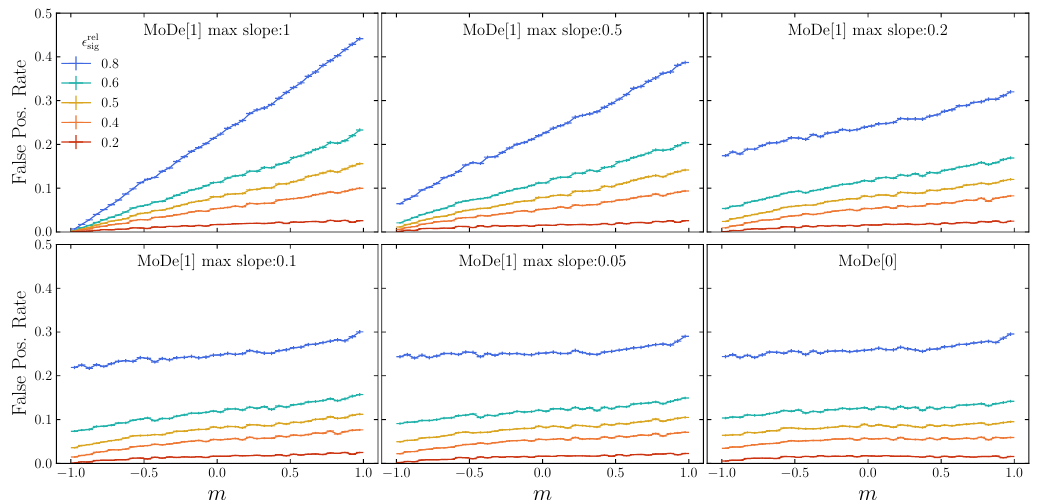
Figure 5 . Results for MoDe [1] on the modified simple-model example requiring various maximum slope